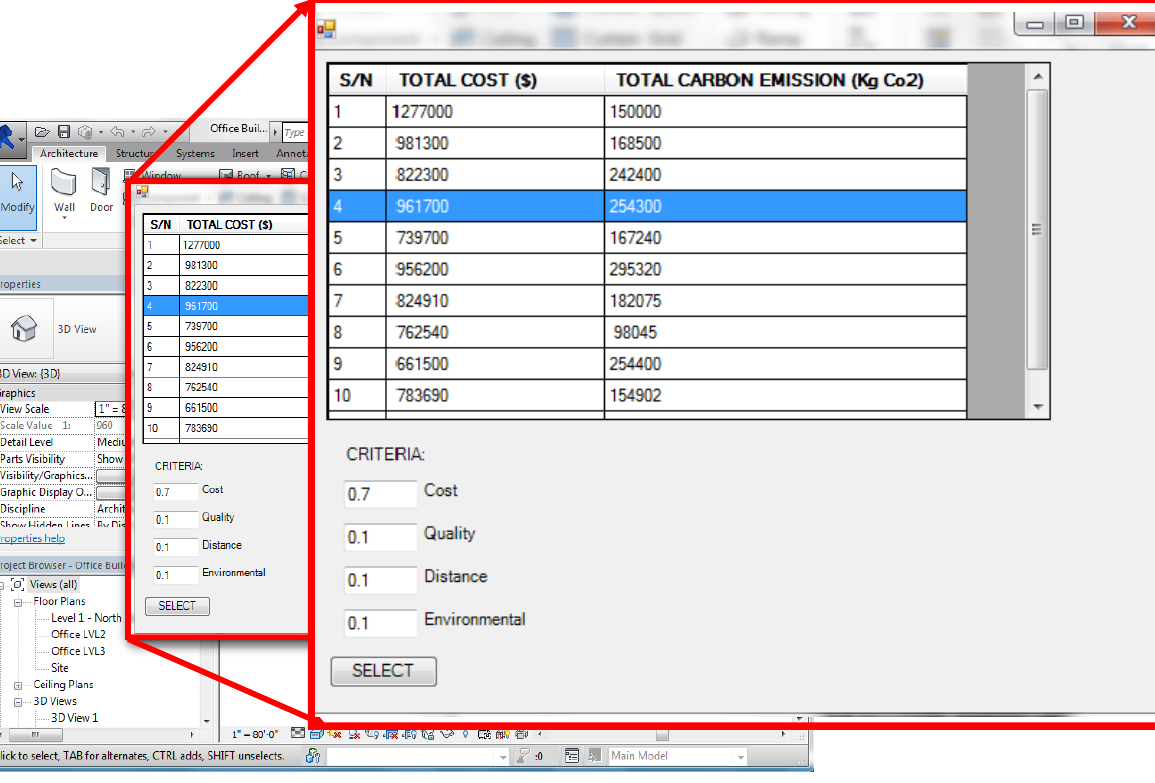
Figure 7. Model Interface showing